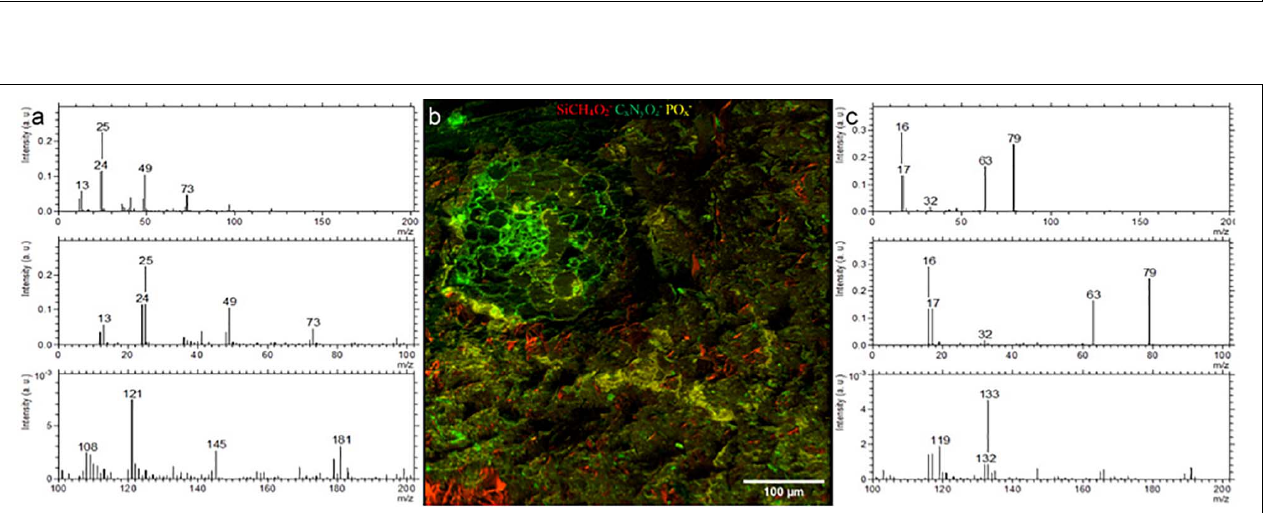
FIGURE 4 | ToF-SIMS analysis of a Rhizosphere embedded sample. (a) Spectrum of LR white (b) Molecular fragment distribution related to SiCH 4 O 2 − , CNO − and PO x − (c) spectrum of PO x − rich